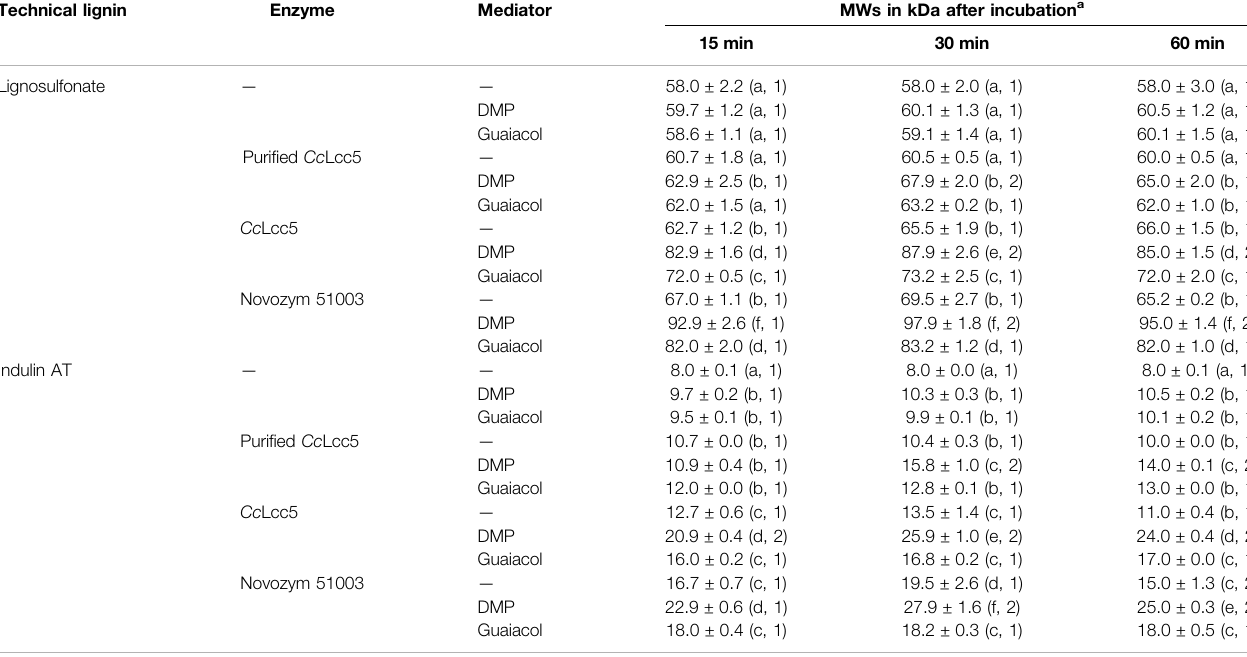
TABLE 1 | Changes in MWs of technical lignins due to incubation with laccases and LMSs for different times in McIlvaine buffer (pH 6.0). Technical lignin Enzyme